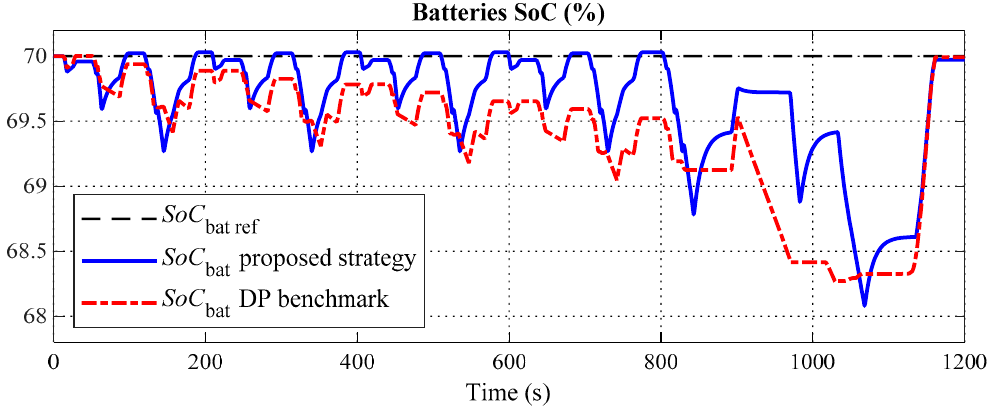
Figure 9. (Simulation) batteries SoC evolutions with NEDC.